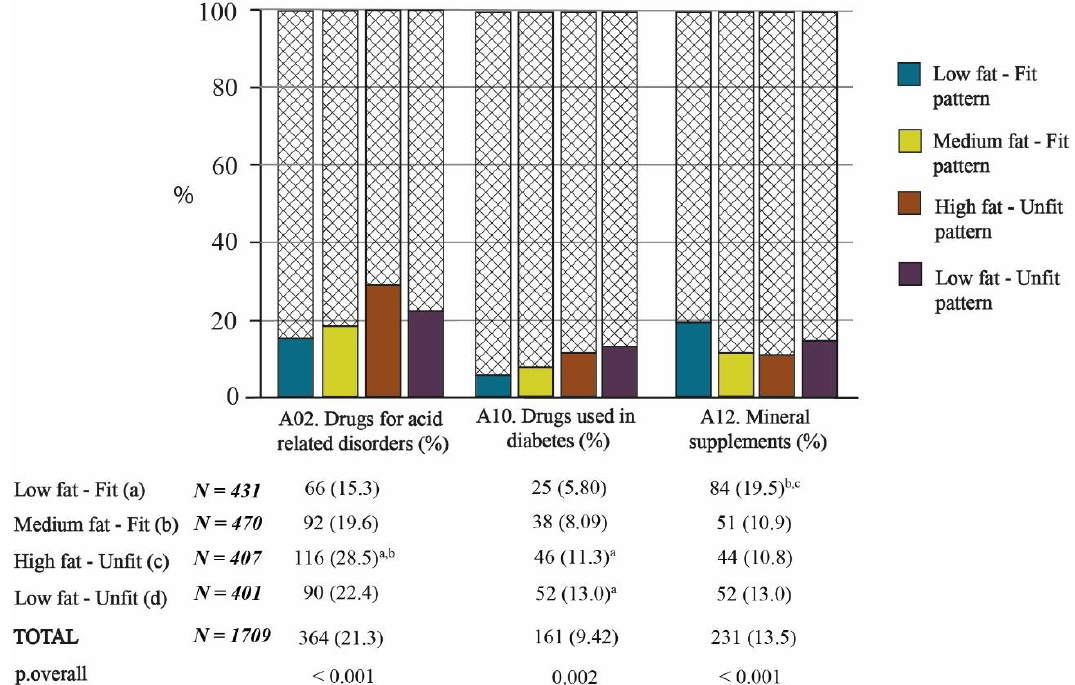
Figure 3. Consumption of drugs related to the alimentary tract and metabolism according to the Fat–Fit patterns. The statistical significance of the proportions between groups can be observed in the columns. The letters in superscript indicate the bilateral comparisons that are significantly different ( p < 0.05).